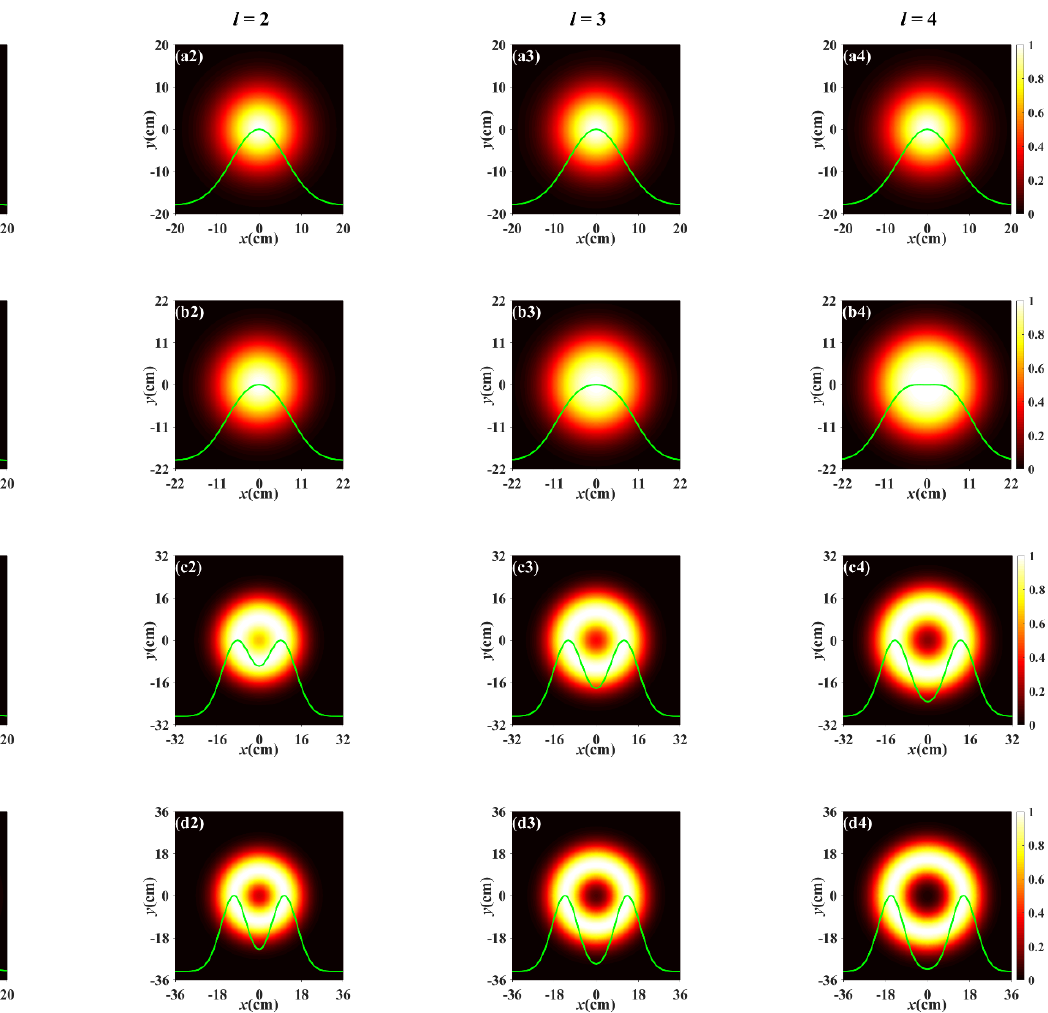
Figure 6. Normalized spectral intensity distribution of the PCTLGP beam propagating through the anisotropic turbulence for different twisted factors and topological charges (C ̃ 2 n = 5 × 10 − 14 m 3 − α , ξ x = ξ y = 2, L = 2 km, n =